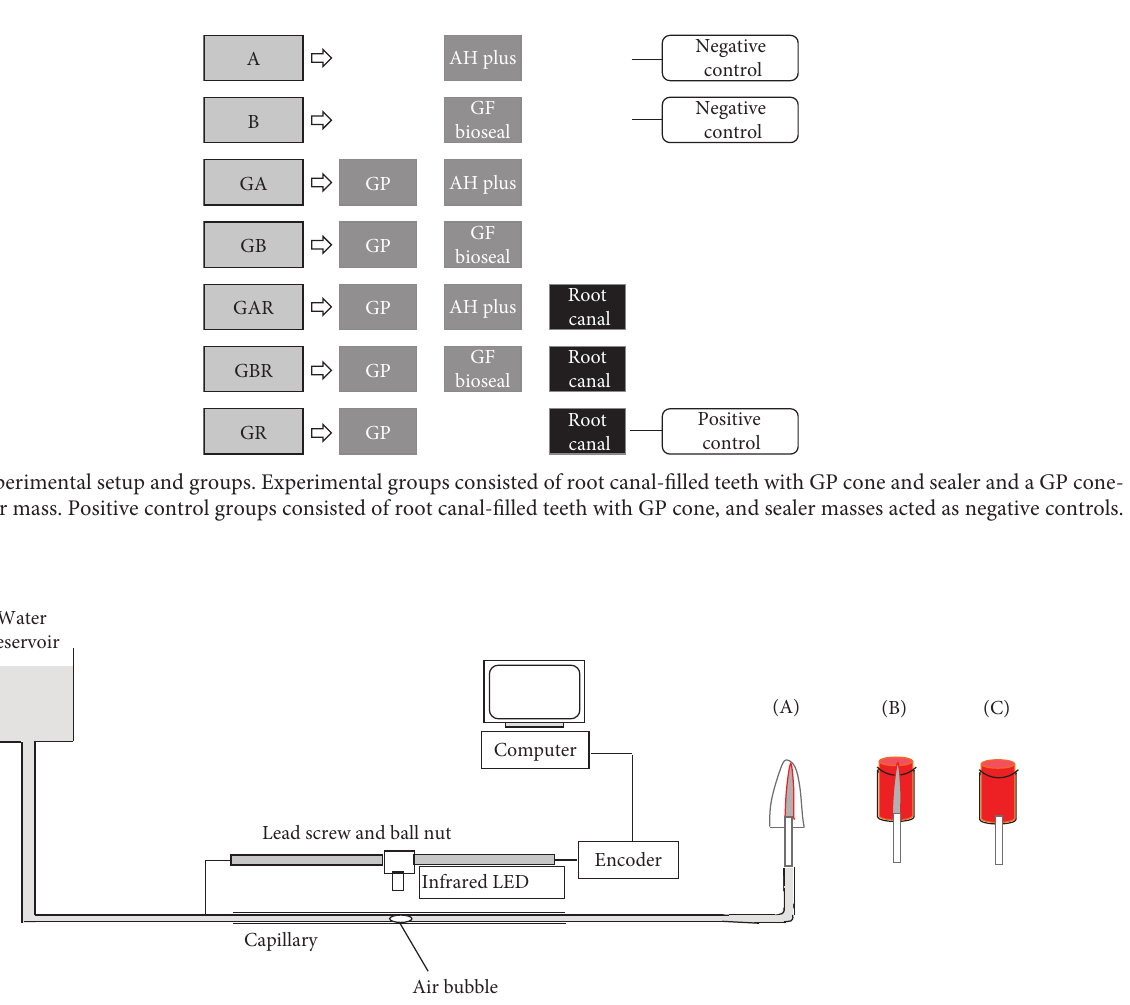
Figure 2: A schematic diagram of a subnanoliter-scaled fluid-flow measuring device connected to a root canal-treated tooth (A), a GP cone- inserted sealer mass (B), and a block of sealer